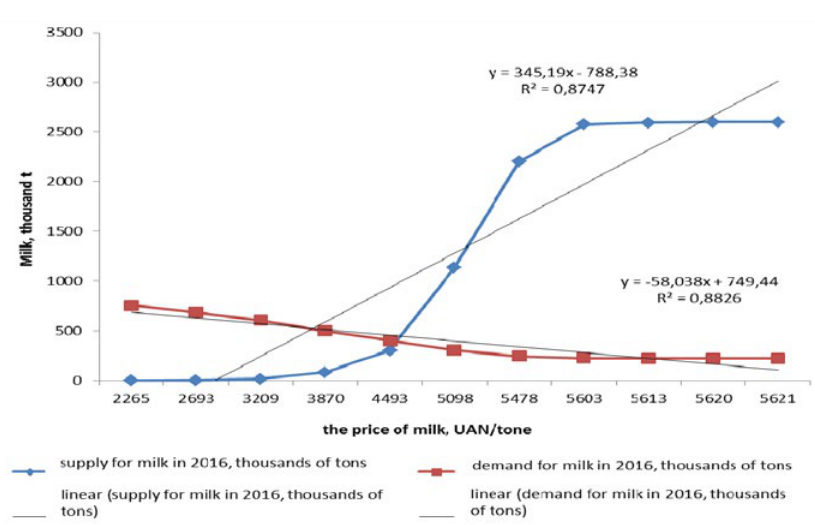
Fig. 2: Correlation of supply and demand for milk in 2016